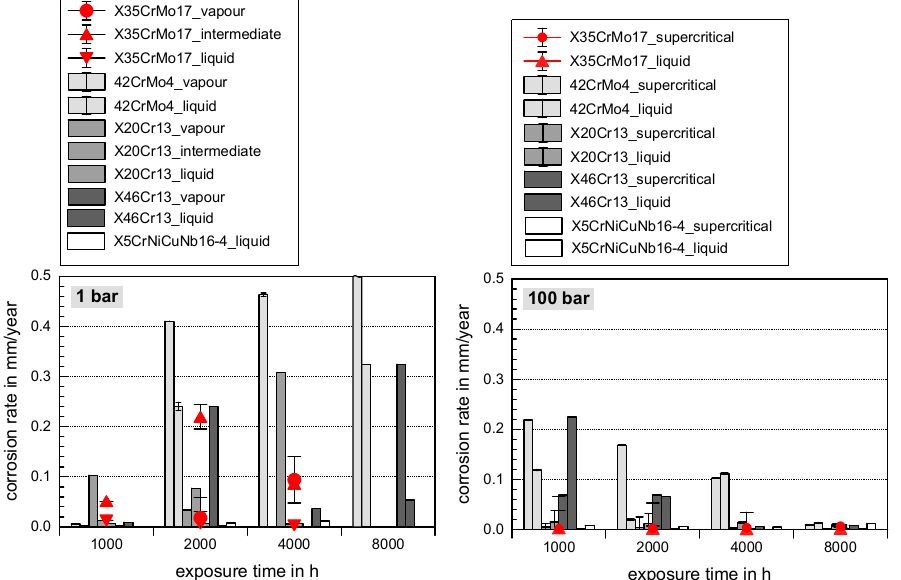
Figure 2. Comparison of corrosion rates of X35CrMo17 to X20Cr13, X46Cr13, 42CrMo4 and X5CrNiCuNb16-4 exposed to liquid and vapour/supercritical CO 2 -saturated geothermal environment at ambient pressure ( left ) and 100 bar ( right ) after exposure for 8000 h to aquifer brine water at 60 ◦ C. Results were taken from [9,15–17,42] and